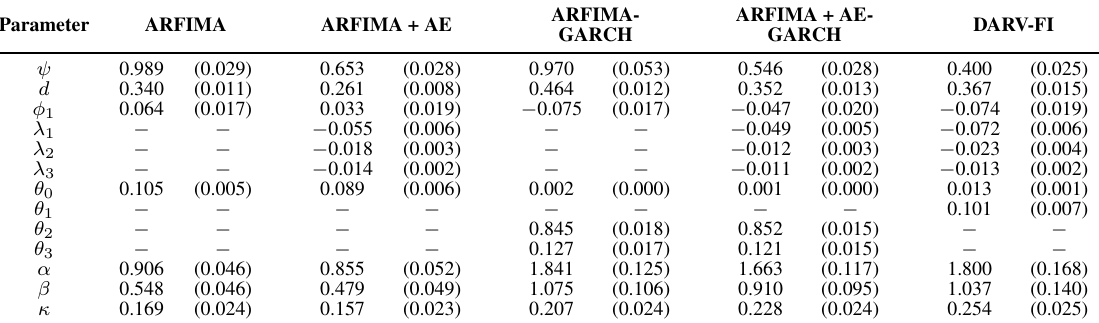
Table 4. Estimated parameters (S&P 500): ARFIMAmodels. DARV, dually asymmetric realized volatility; AE, asymmetric